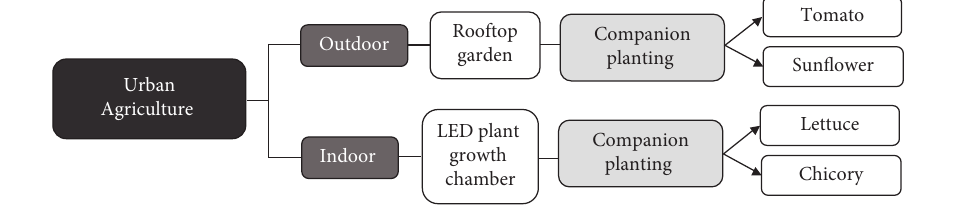
Figure 1: Flowchart of the study. Table 1: Growth conditions for companion planting of urban agriculture. Urban agriculture